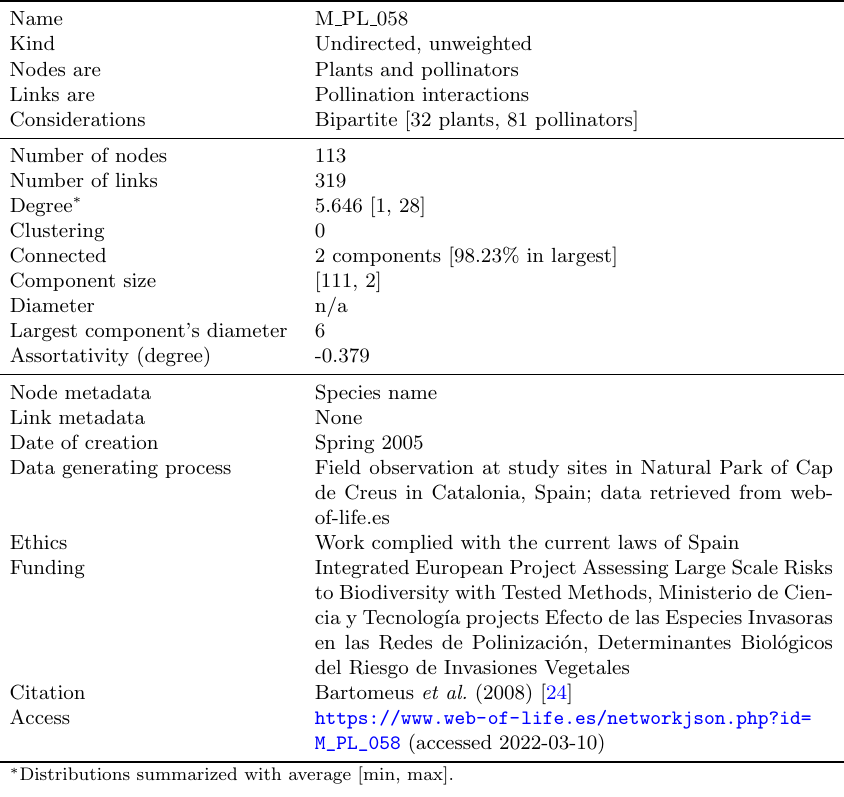
Table 2 Network card for a plant–pollinator